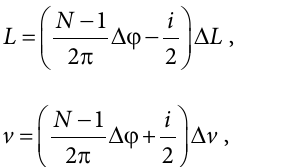
the object can be unambiguously determined.